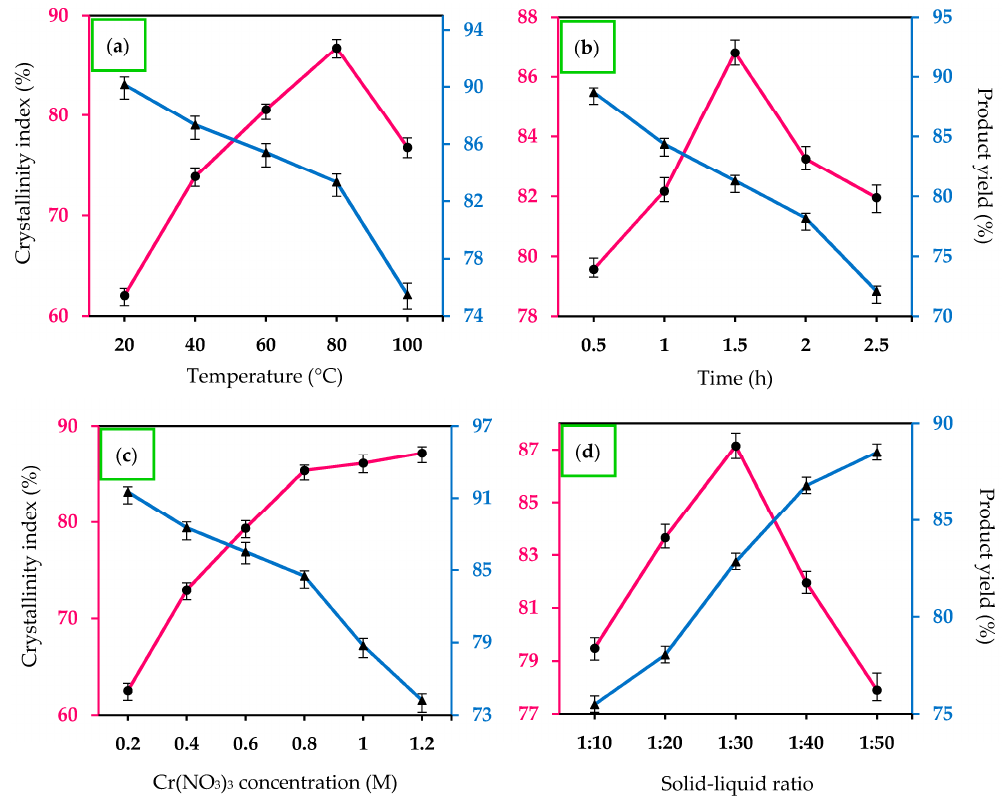
Figure 1. Effects of: ( a ) Reaction temperature; ( b ) Hydrolysis time; ( c ) Cr(NO 3 ) 3 concentration; and ( d ) Water content on the crystallinity index and yield of nanocellulose